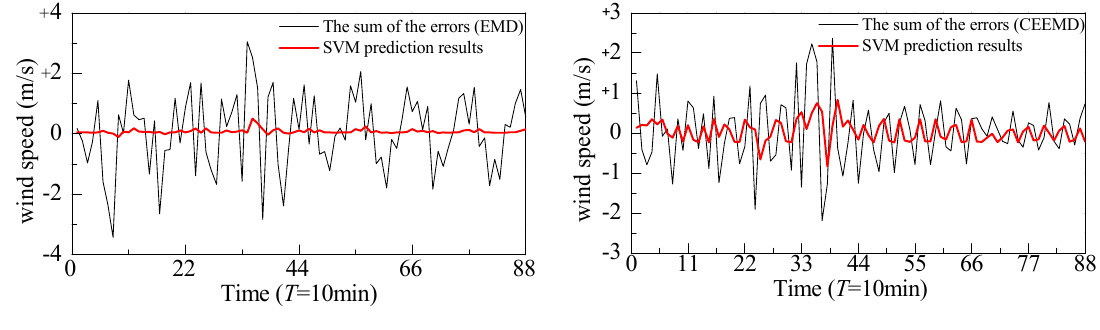
Figure 4. ARIMA prediction results.